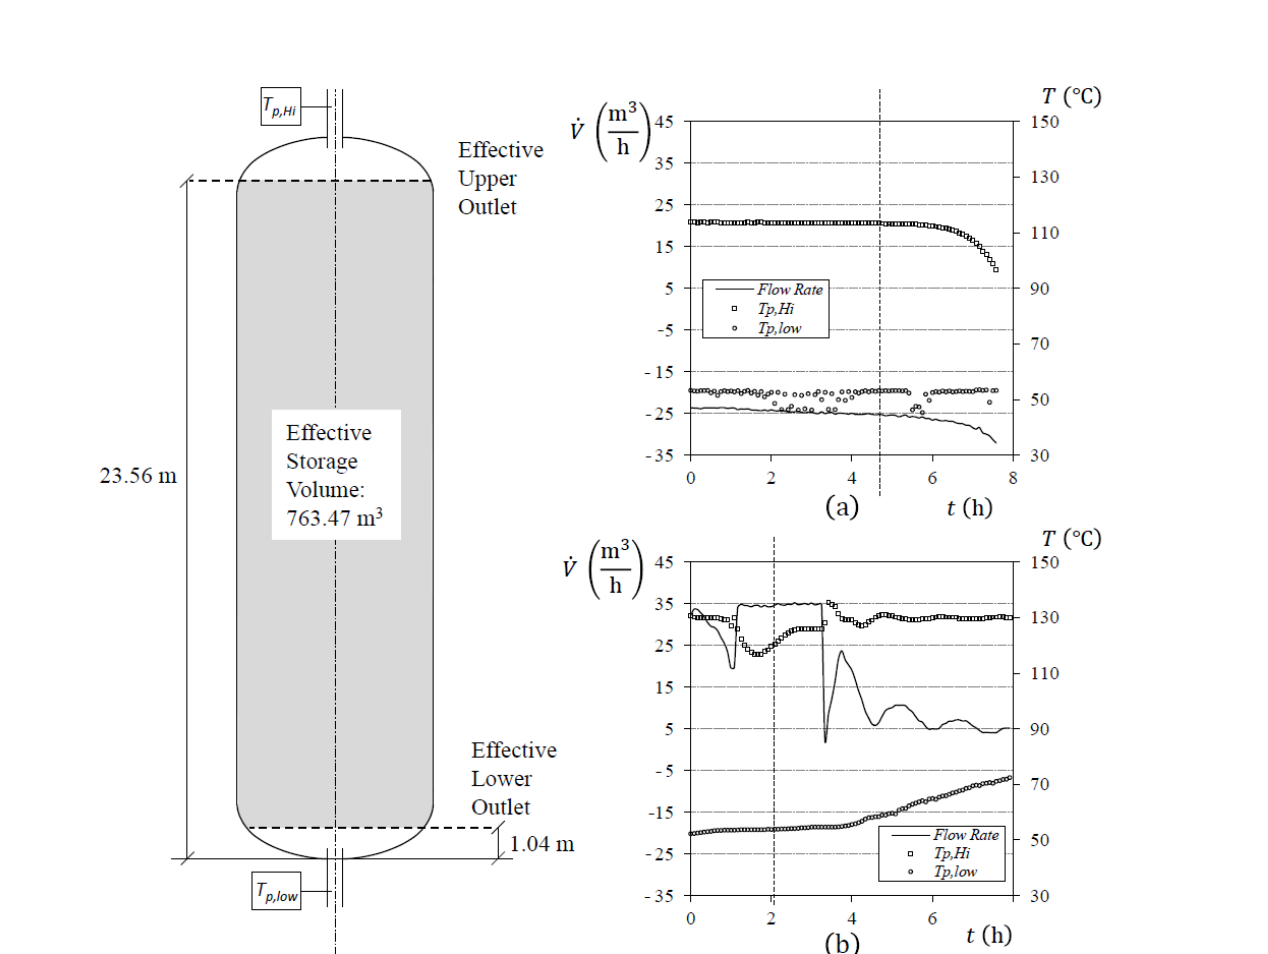
Figure 5. Scheme of the effective outlets and effective storage volume obtained from analysis of periods when: ( a ) thermo- cline reaches upper outlet in discharge; ( b ) thermocline reaches lower outlet in